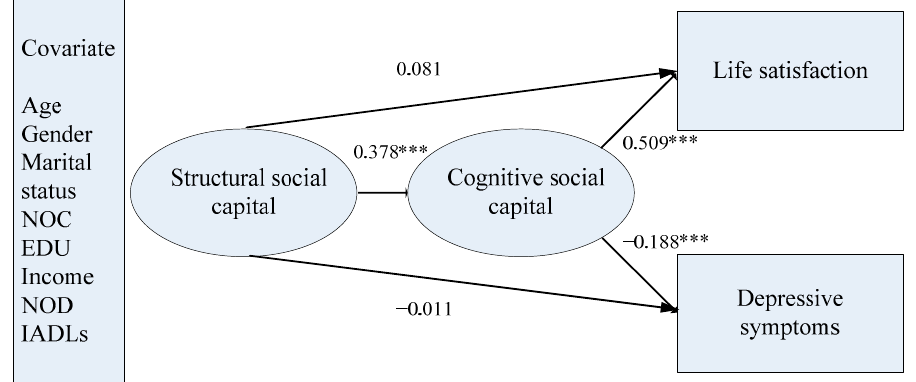
Figure 1. The structural model of social capital and mental health. Notes: Only standardized coefficients are reported. *** p < 0.001 (two-tailed); NOC = number of children; EDU = educational attainment; NOD = number of chronic diseases; IADL = instrumental activities of daily living.